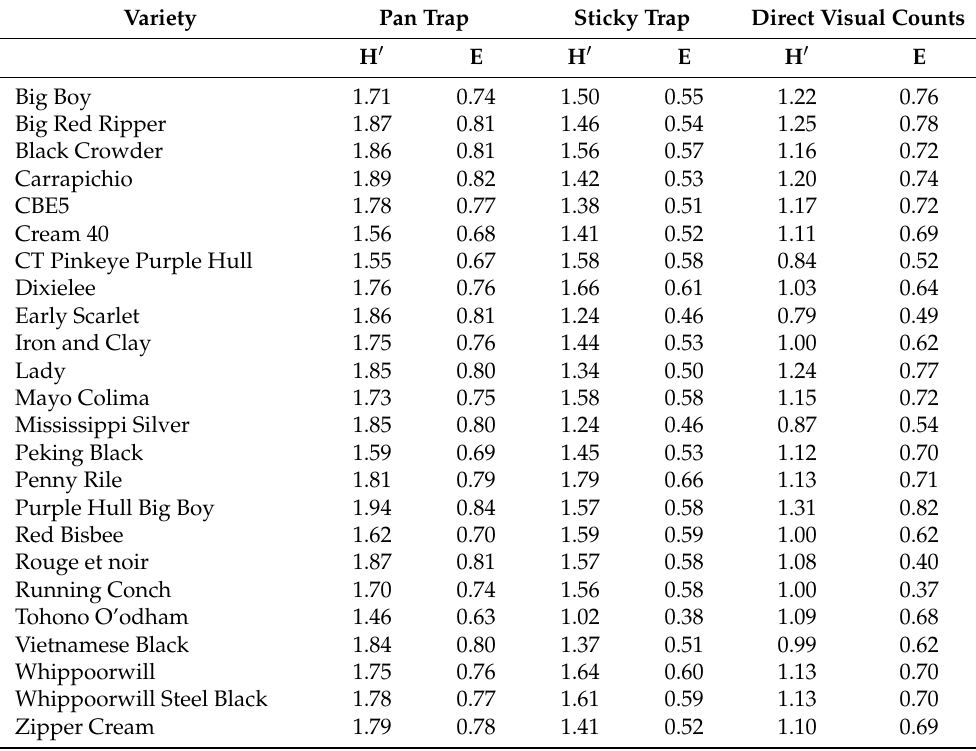
Table 4. Diversity index (H (cid:48) ) and Evenness (E) of insect families in pan traps, sticky traps, and from direct visual counts recorded on cowpea